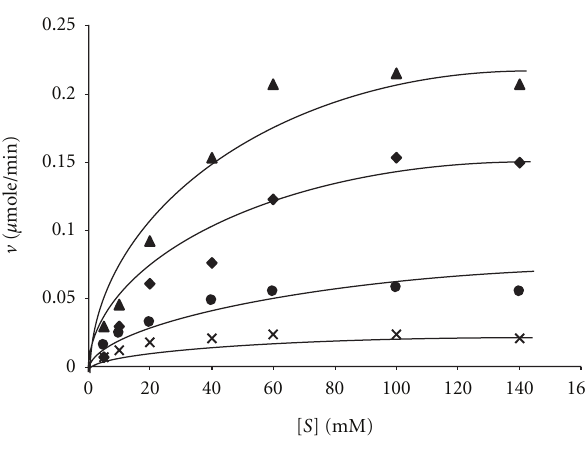
Figure 4: The steady-state rate of Mn(III) formation in presence of 20mM succinate bu ff er (X), 0.5mM oxalate in 10mM succinate bu ff er ( (cid:2) ), 20 mM lactate bu ff er ( (cid:2) ), and 40mM malonate bu ff er ( (cid:3) ) each of pH 4.5 at 30 ◦ C. The reaction solution 1mL contained 5 μ g of the enzyme (4IU/mg), 100 μ M H 2 O 2 , and MnSO 4 was